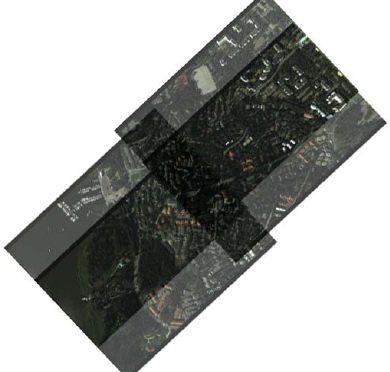
Figure 1. Overview of the DMC (RGB) image block.